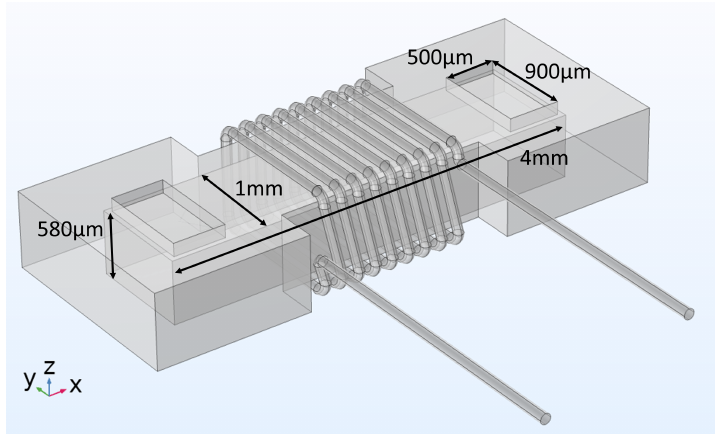
Figure 5. Model of the micro-inductor in Comsol